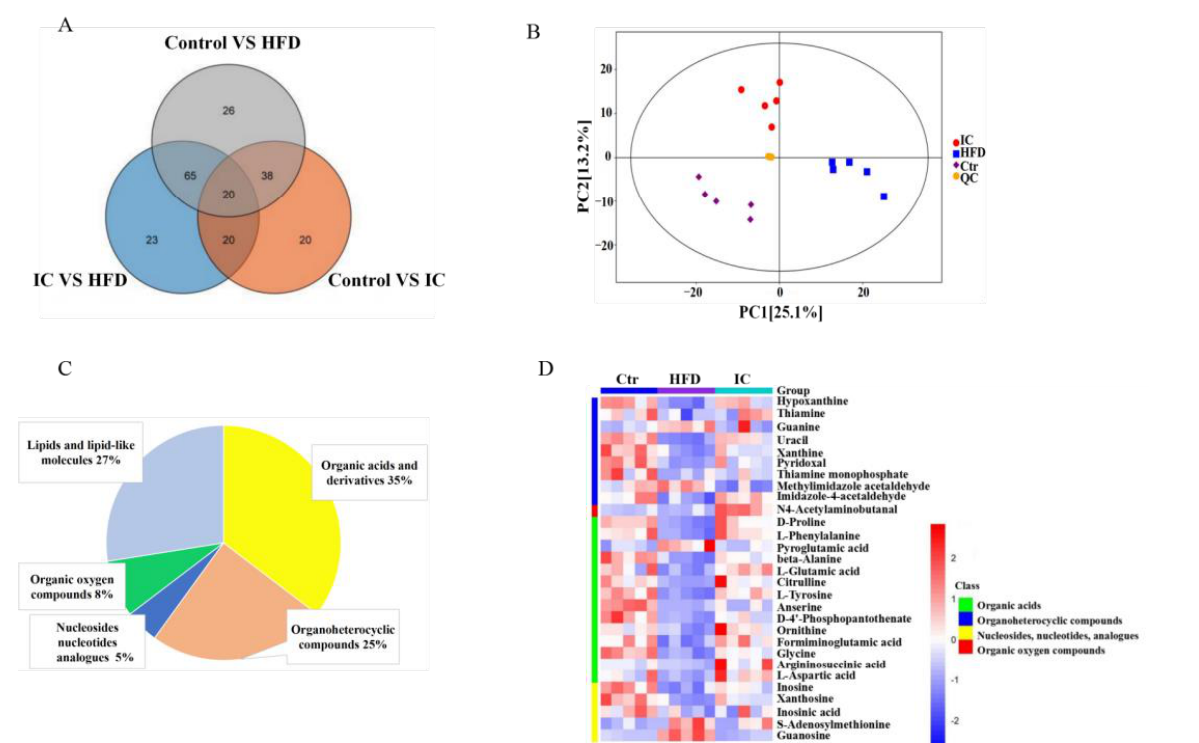
Figure 7. Metabolite classes and compositions in the samples. ( A ). The overall differential metabo- lites. ( B ). Serum metabolic profiles of the three groups using a principal component analysis (PCA) score plot. ( C ). Pie chart indicating the abundance ratio of different chemical classes of annotated metabolites identified by untargeted metabolic profiling in liver samples. ( D ). Heatmap showing the differences in expression of the differential metabolites in the three groups. Red and blue colors indicate higher or lower expression, respectively, in each sample.